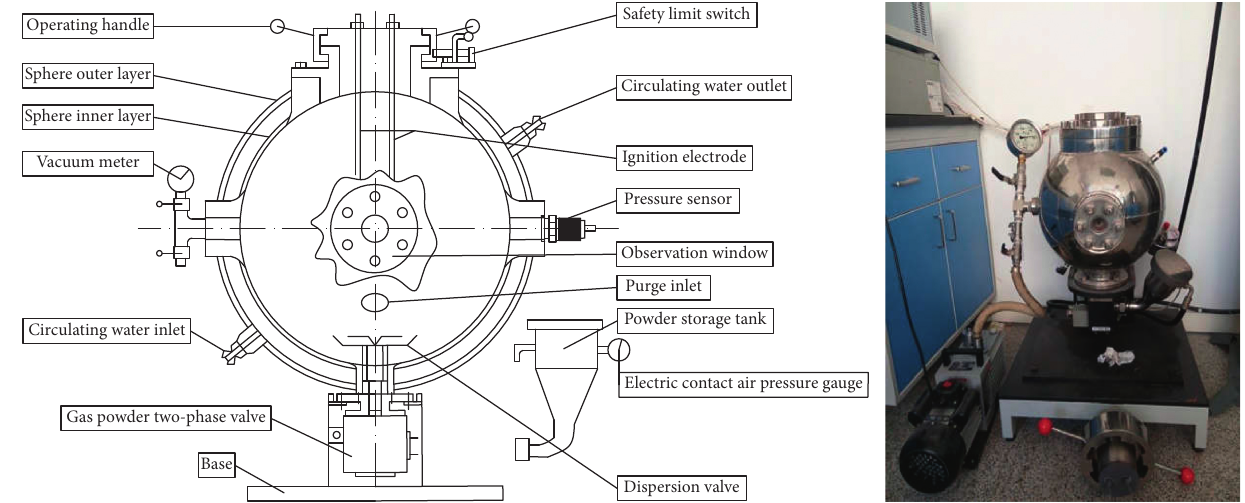
Figure 5: 20L explosion sphere vessel schematic diagram and physical diagram.